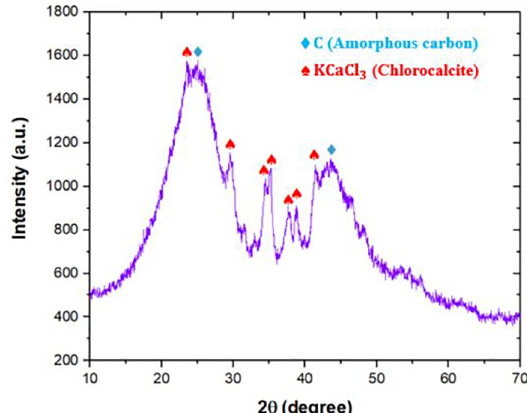
Figure 2. XRD spectrum of produced porous carbon